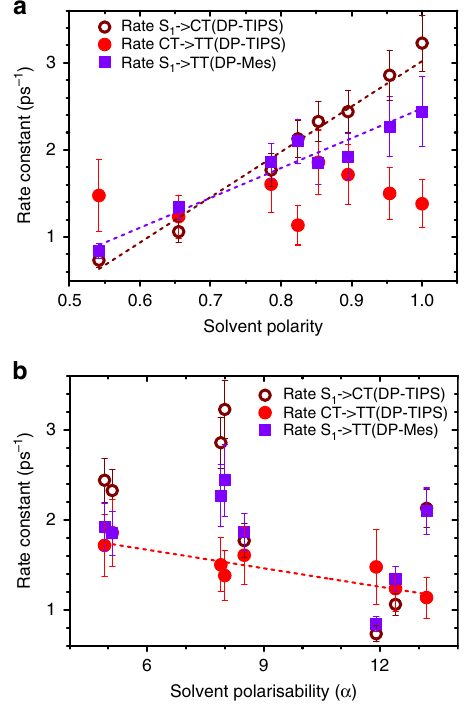
Figure 6 | Solvent-dependent SF rate constants. ( a ) The SF rate for DP-Mes (S 1 - TT, purple) and the rate of S 1 - CT conversion in DP-TIPS (brown) both depend linearly on solvent polarity. The polarity dependence of CT - TTconversion (red) in DP-TIPS is complex, ( b ) but the rate exhibits moderate correlation with polarisability. Lines are linear fits. Rates were determined from population kinetics and yields extracted from TA, as described in Methods and Supplementary Note. Error bars reflect propagation error from calculating triplet yield and exponential fitting of the conversion rate.